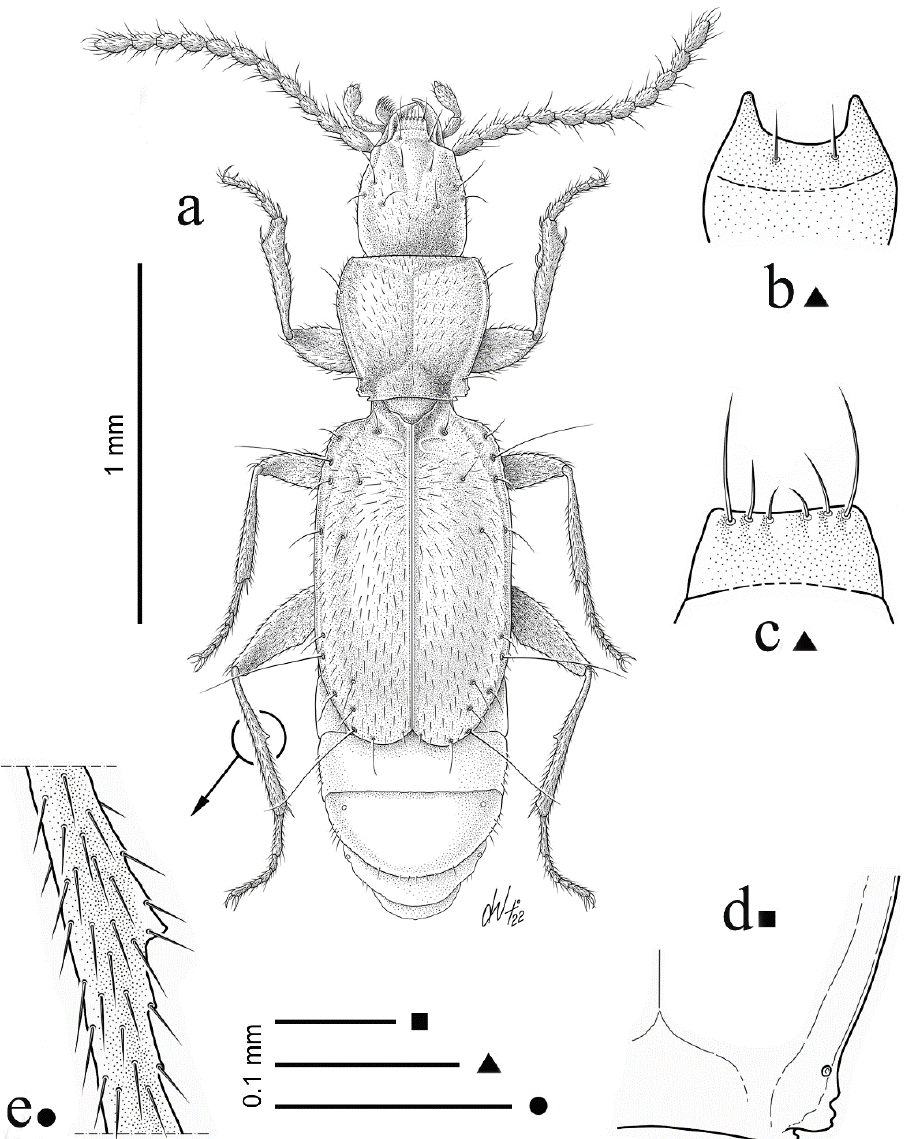
Figure 1. Iason assingi n. sp. HT ♂ . a: habitus; b: labium; c: labrum; d: basal angle of the pronotum; e: metatibial tooth.